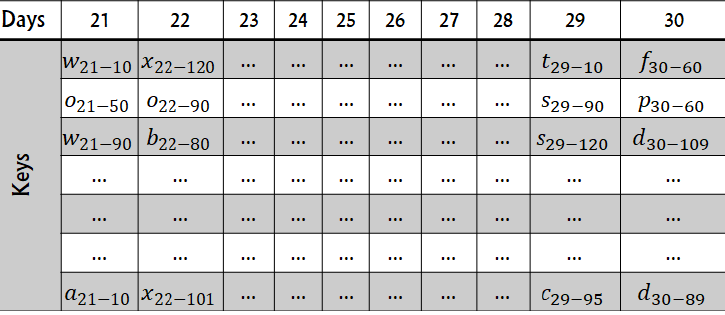
Figure 6. Example of diagnostic keys uploaded to the server by an infected individual.